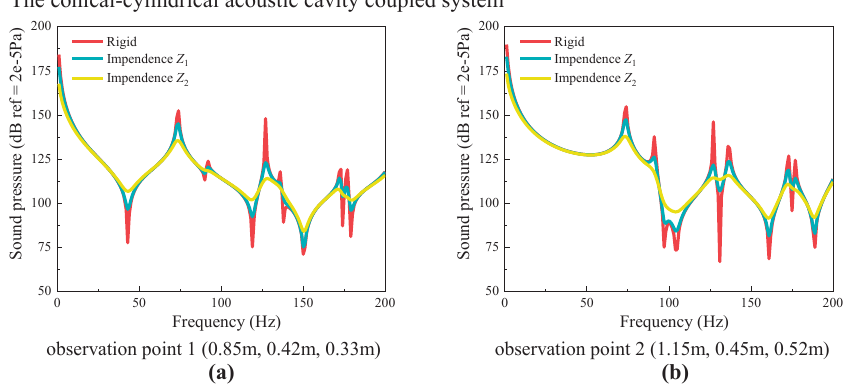
Figure 10. Sound pressure response curves of the coupled systems under the excitationofa point source with different impedance value of the acoustic